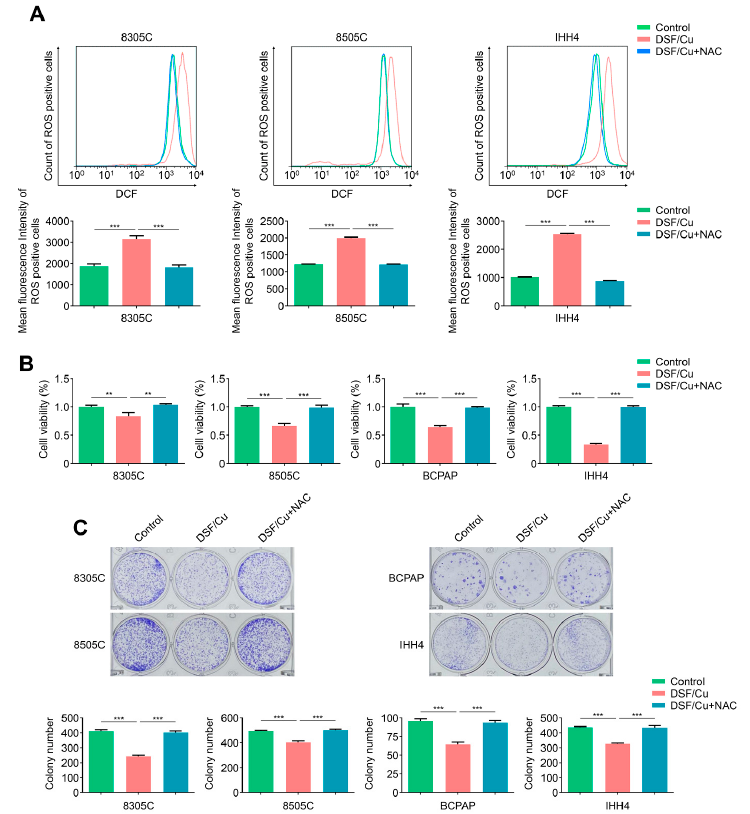
Figure 2. DSF/Cu kills thyroid cancer cells in an ROS-dependent way. ( A ) BRAF V600E -mutated thyroid cancer cell lines 8305C, 8505C and IHH4 were treated with 0.5 µ M DSF/Cu alone or in combination with 2 mM NAC for 48 h, followed by a 1.5 h incubation with ROS-sensitive fluorescent dye DCF-DA. The ROS-positive cells were measured by flow cytometer (upper panels), and the mean fluorescence intensity of three independent experiments was then calculated by Student’s t test (lower panels). ( B ) The indicated cells were treated with 80 nM DSF/Cu alone or in combination with 2 mM NAC for 48 h, and cell viability was then measured by MTT assay. ( C ) Colony formation assay was performed when these cells were treated with DSF/Cu (8305C, 8505C and BCPAP: 50 nM, IHH4: 40 nM) alone or in combination with 2 mM NAC for 8–10 days. Data presented as means ± SD. ** p < 0.01; *** p < 0.001.